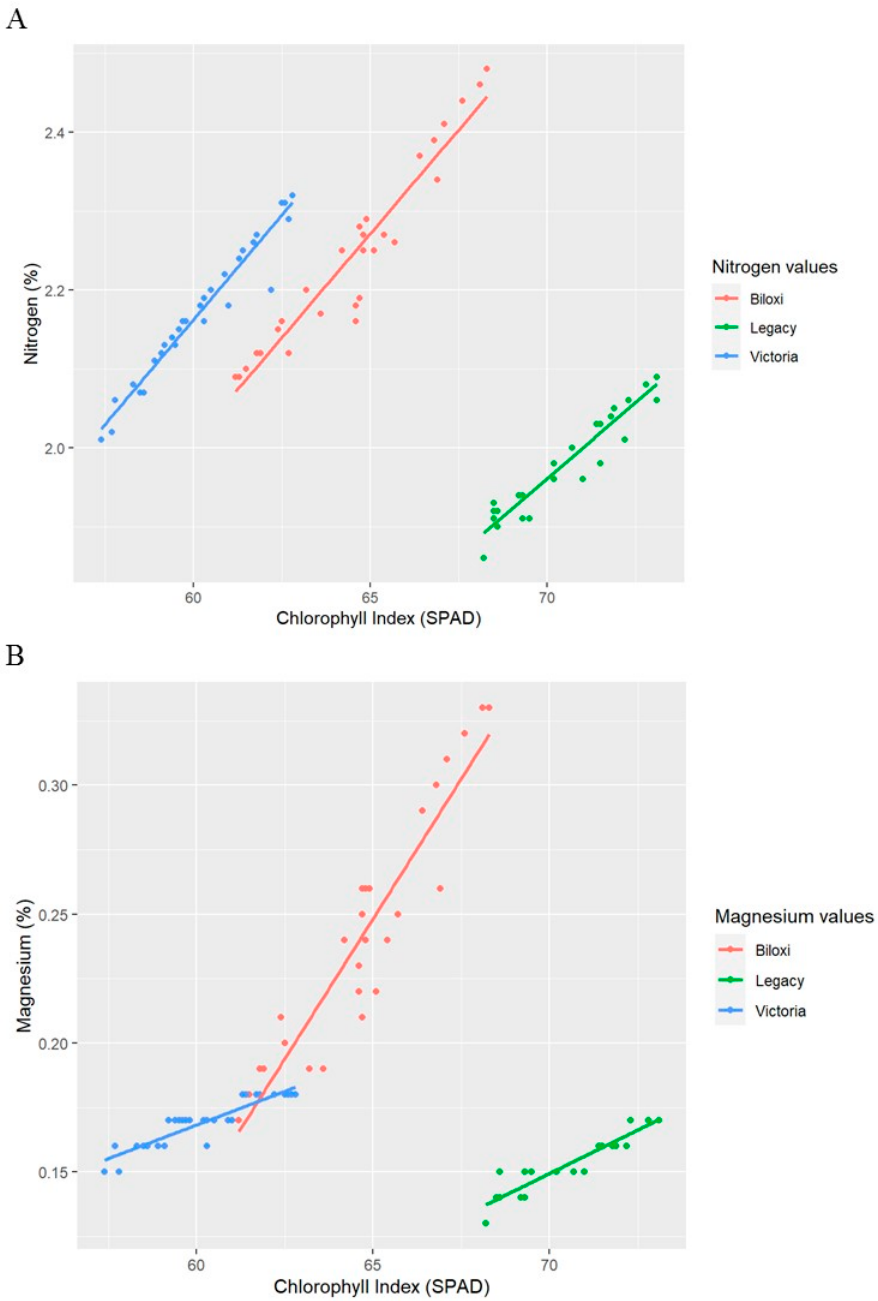
Figure 7. Linear relationship between the SPAD chlorophyll index and the foliar nitrogen content ( A ) and the foliar magnesium content ( B ) in Biloxi, Legacy and Victoria variety blueberry plants. Table 2. Linear regression parameters between SPAD units and nitrogen and magnesium content in three blueberry cultivars under conditions of the Colombian high tropics.